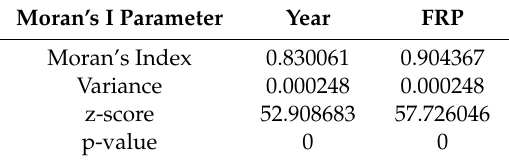
Figure 8. Result of Moran’s I index for ( a) the forest fire years and (b) the FRP. Table 3. Result of Moran’s I index